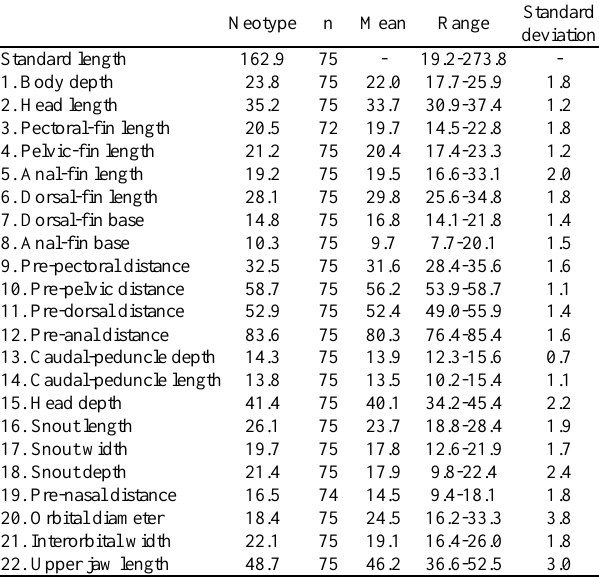
Table 4. Morphometric data of Hoplias brasiliensis . Standard length in mm; values 1-14 are percents of standard length and values 15-22 are percents of head length. n = number of examined